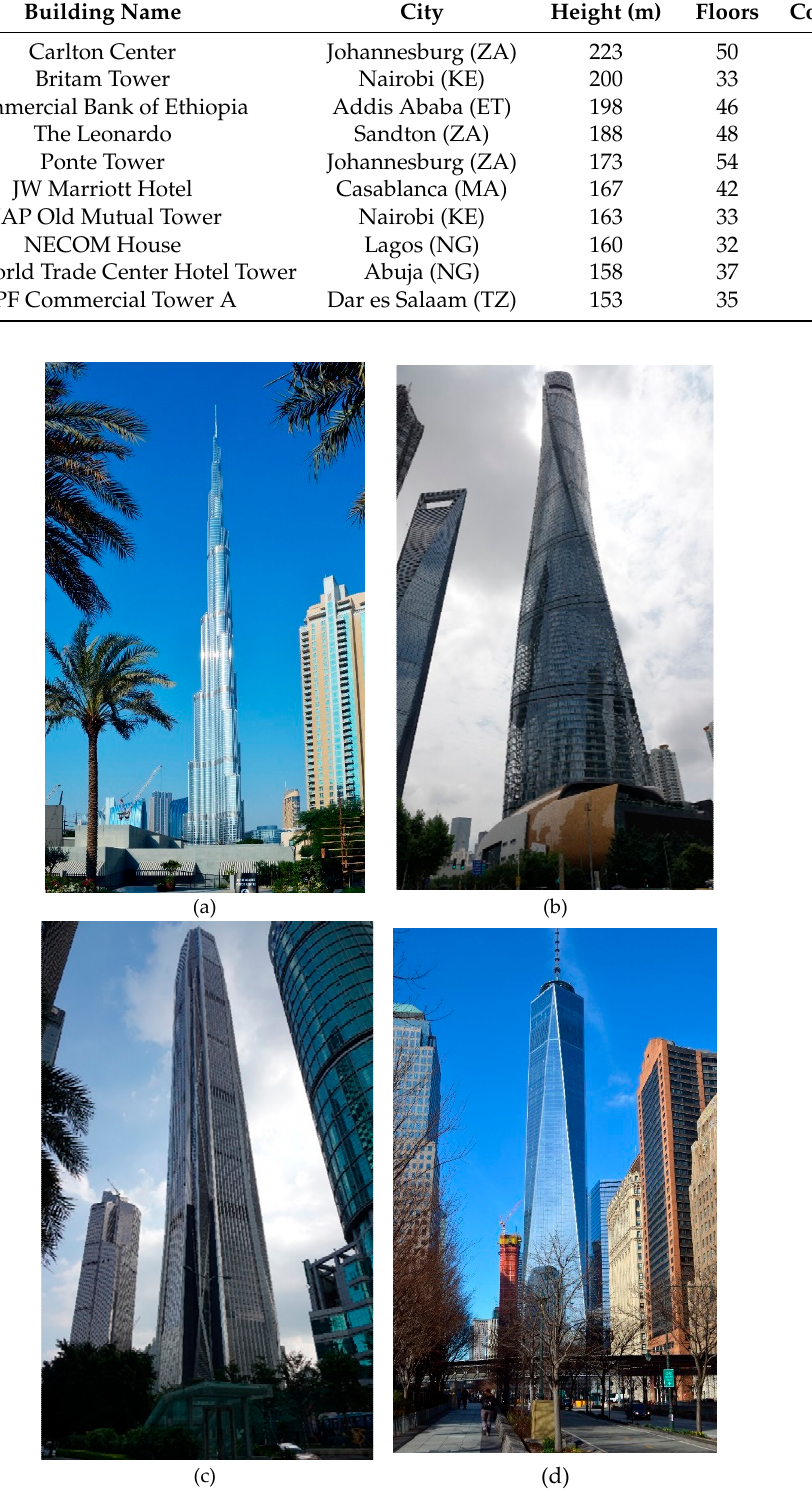
Figure 1. Examples of world’s tallest buildings built in the 21st Century: ( a ) Burj Khalifa (828 m), ( b ) Shanghai Tower (632 m), ( c ) Ping An Finance Center (562 m), and ( d ) One World Trade Center (541 m), ( Photographs by author ).